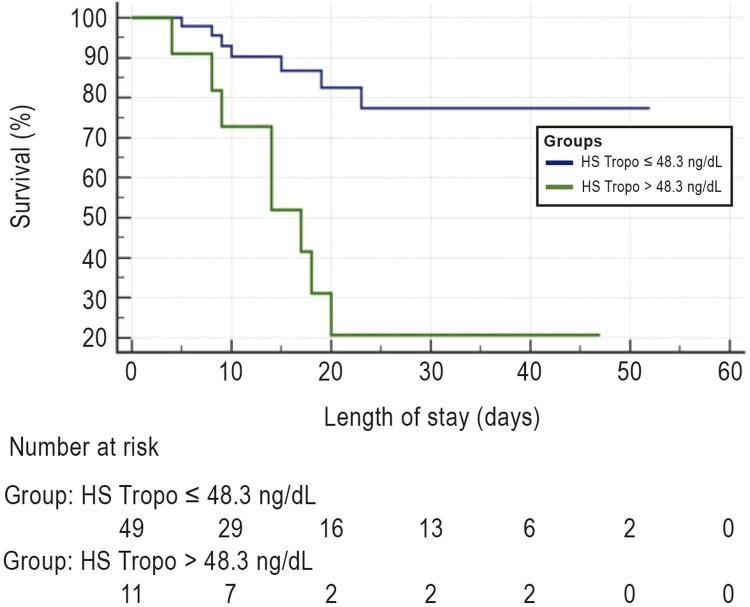
– Survival of patients with COVID-19 admitted to the intensive care unit with and without myocardial injury, Kaplan-Meier method. HS-Tropo: high-sensitivity troponin.